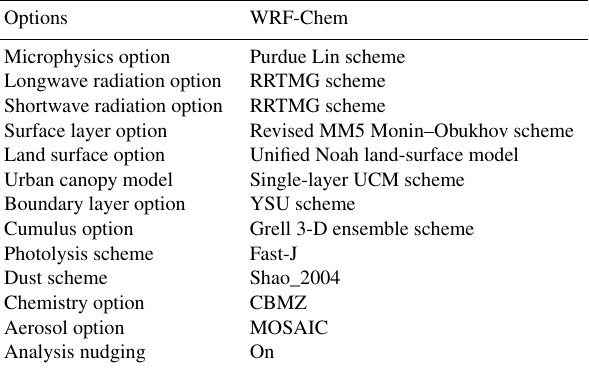
Table 1. Parameterizations used in the WRF-Chem model.